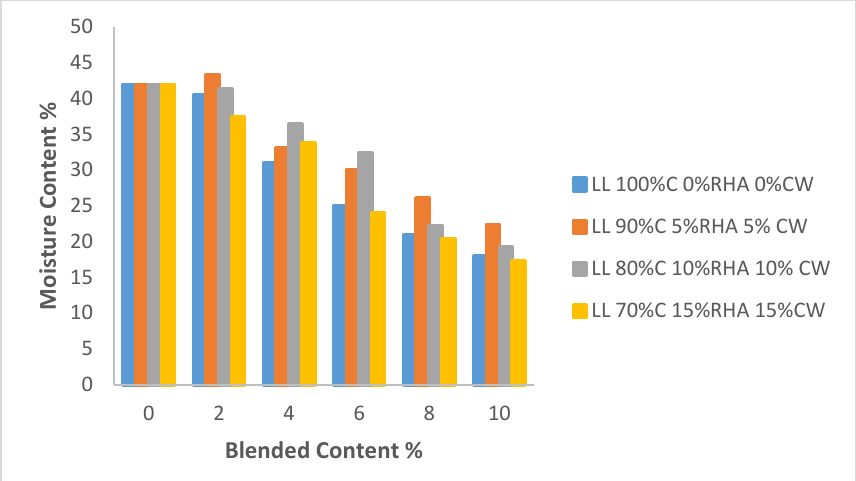
Fig. 2. Relationship between the LL of (100%C 0%RHA 0%CW), ( 90%C 5%RHA